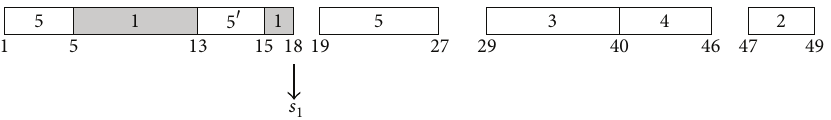
Figure 7: Semipreemption-based adjustment of 𝑟 1 (Example 2).